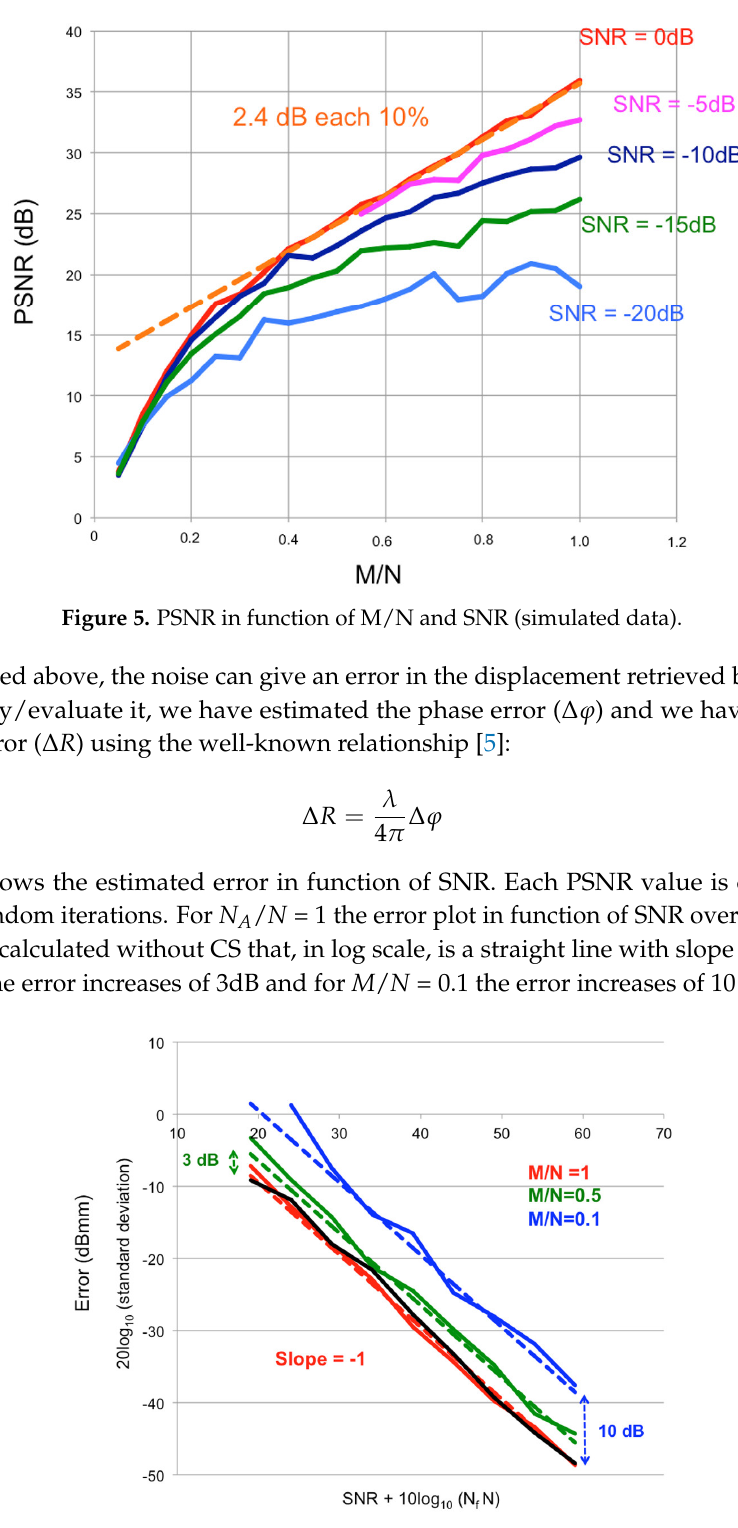
Figure 6. Displacement error in function of SNR for different M/N (simulated data). The dark line is the displacement error calculated without CS technique.